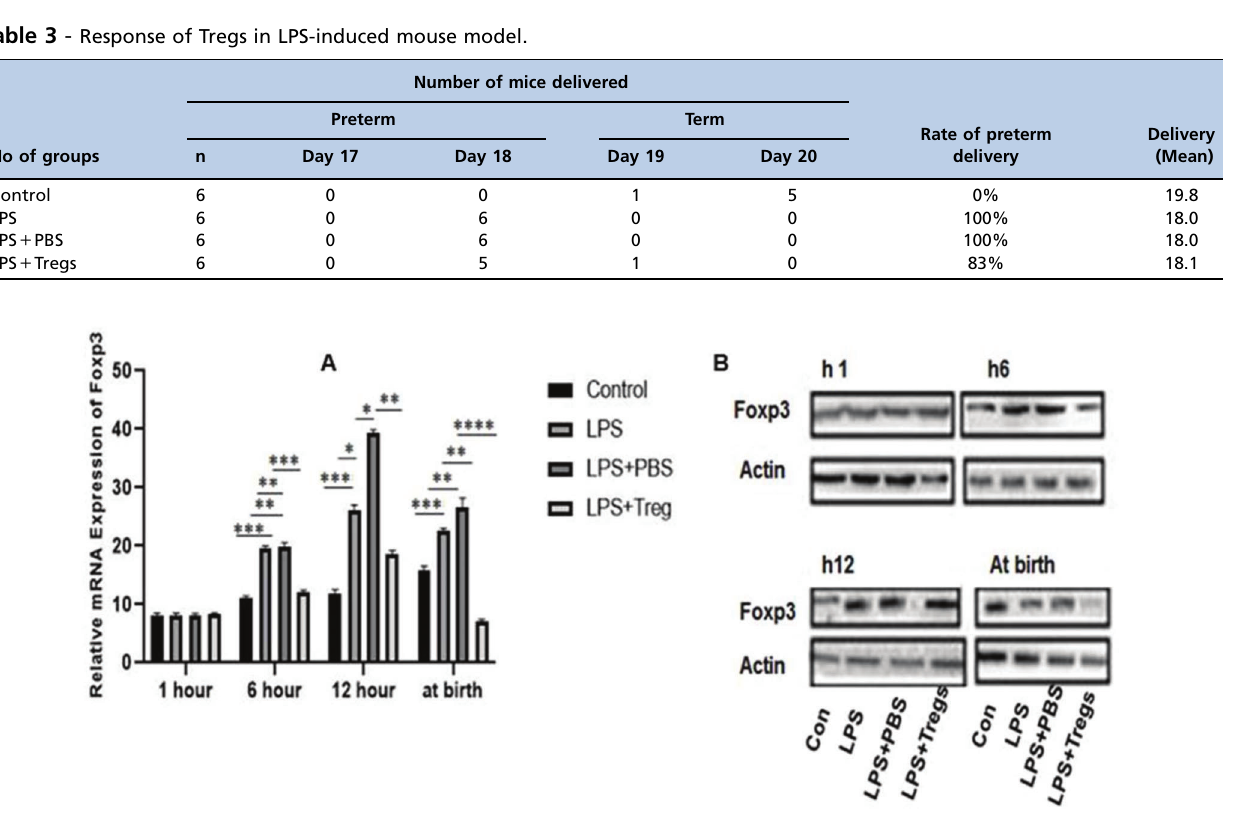
Figure 1 - Statistical analysis of Foxp3 expression in different groups. (A) The expression levels of Foxp3 among different groups of model mice were analyzed. The mRNA expression of Foxp3 in the LPS and LPS + PBS groups was significantly higher than in the control group at 6 h, 12 h, and birth after the second administration of LPS ( p o 0.05). The mRNA expression of Foxp3 in the LPS + Tregs group was significantly lower than that in the LPS and LPS + PBS groups at 6 h, 12 h, and birth after second administration ( p o 0.05; * p o 0.05, ** p o 0.01; *** p o 0.001; **** p o 0.0001). (B) The western blot results showed that the protein expression of Foxp3 in all groups followed a trend similar to that of the Foxp3 mRNA